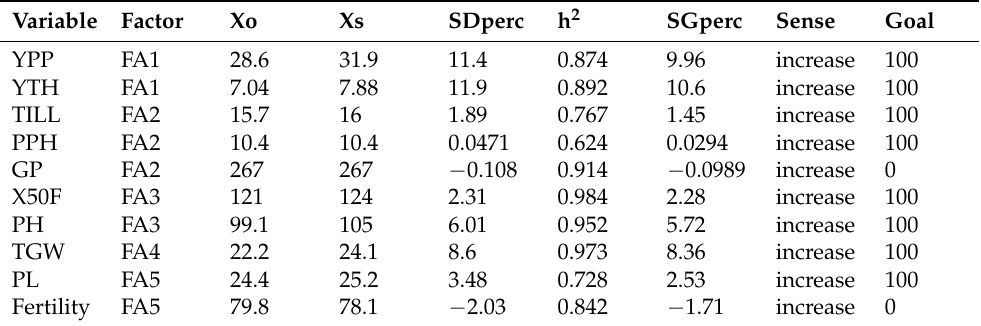
Table 8. Original value (Xo), selected value (Xs), selection differential in percentage (SDperc), heri- tability (h 2 ), and selection gain in percent (SGperc) for the MGIDI in 34 rice genotypes in Kushtia. Variable Factor